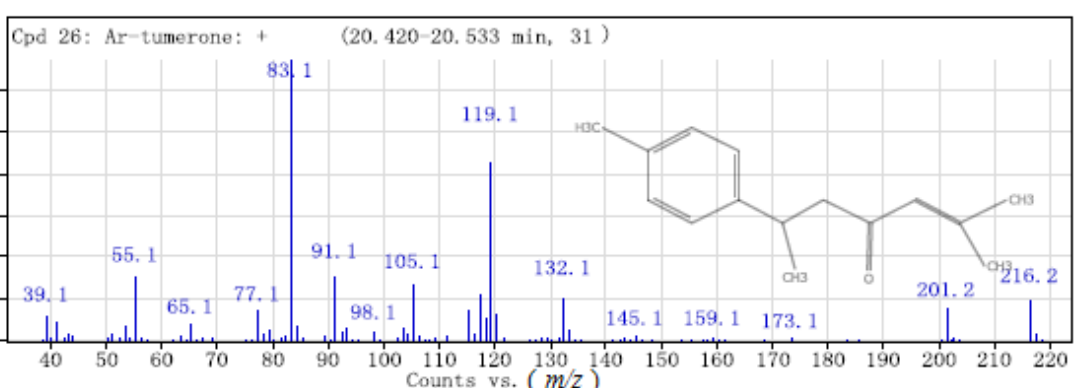
Figure 6. Mass spectrum of curlone. According to the MS data, the compounds of seven characteristic peaks detected by GC-SAW were identified. They are as follows: the peak at the retention indices of 1186, 1414, 1457, 1484, 1525, 1572, and 1667 were attributed to α -terpineol, caryophyllene, trans- α -bergamotene, curcumene, β -sesquiphellandrene, curcumol, and ar-turmerone, respec- tively. However, the retention index of peak 1773 did not find the corresponding chemical substance. Monoterpene and sesquiterpenes compounds are the main volatile components of turmeric. Monoterpene compounds such as α -terpineol has antibacterial effects. The ses- quiterpenes such as caryophyllene, trans- α -bergamotene, curcumene, β -sesquiphellan- drene, and curcumol have anti-inflammatory effects. The main component ar-turmerone has anti-inflammatory, anti-malarial, anti-cancer, and neuroprotective effects [21–23]. The